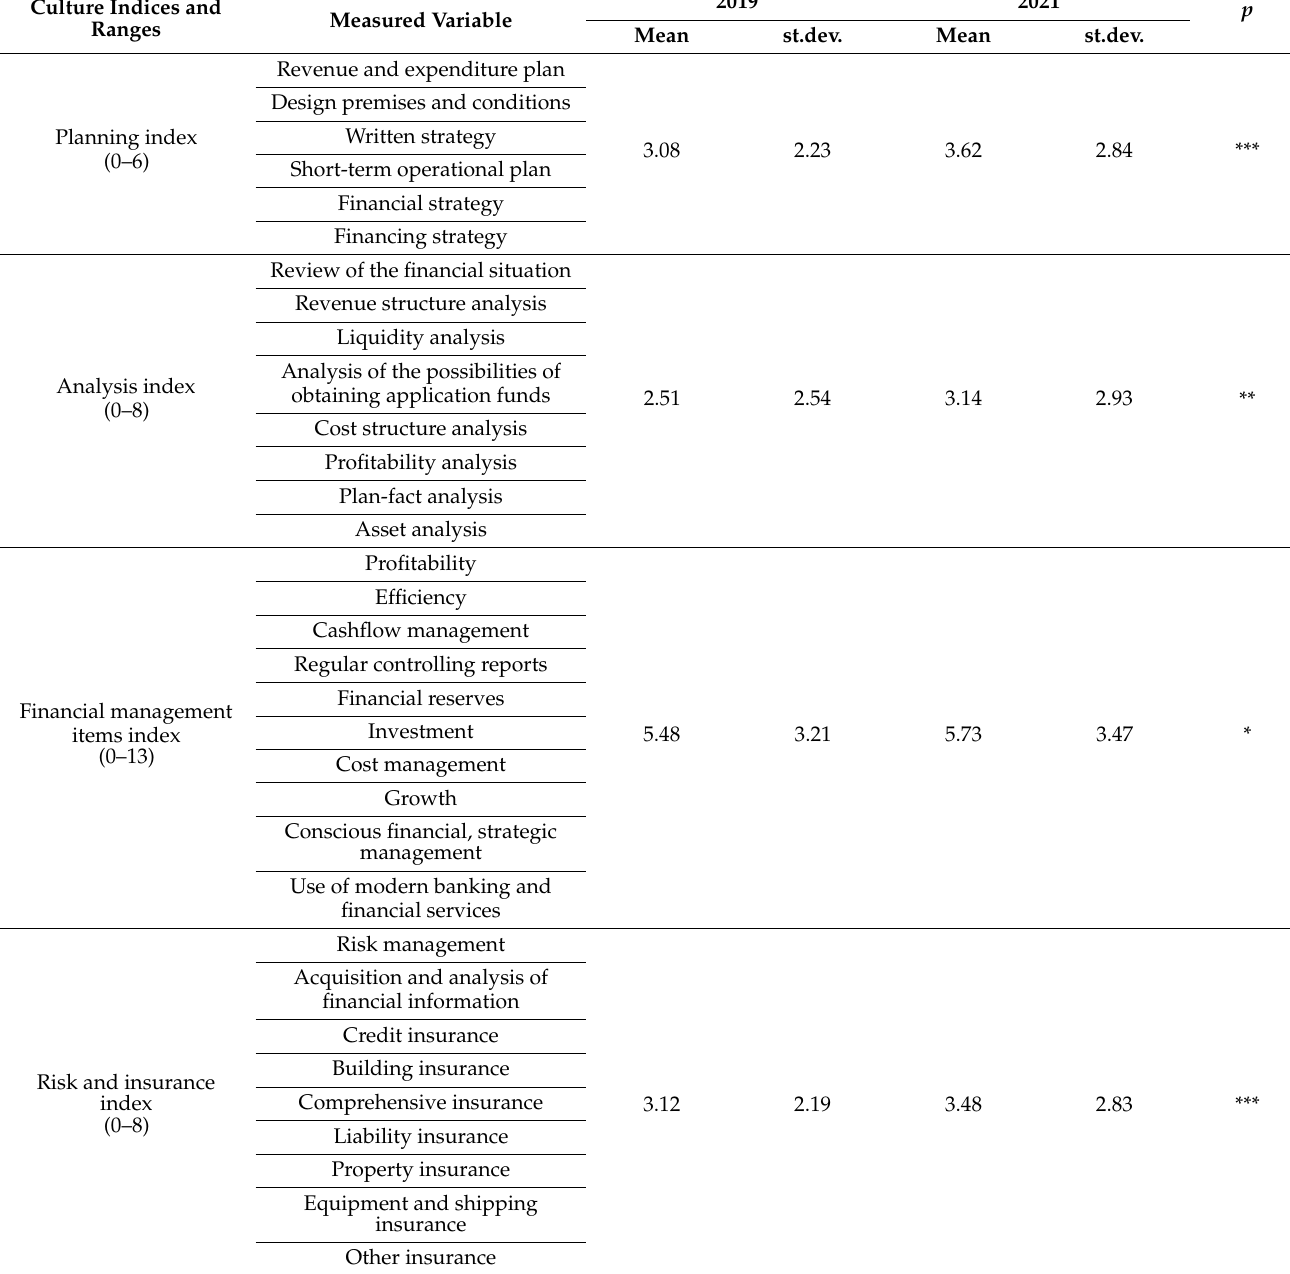
Table 2. Mean and standard deviation of proxy